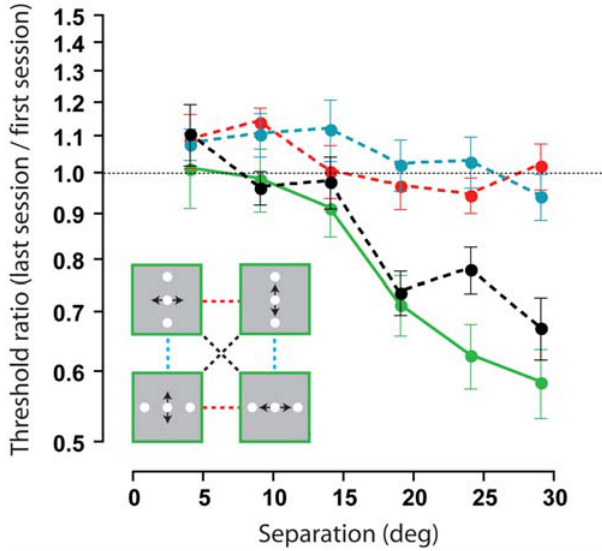
Figure 4. Transfer of learned improvements between task and stimulus configurations. Ratio of mean positional thresholds obtained on the first and last days, collapsed across conditions and plotted as a function of stimulus separation. Trained improvements in performance did not transfer to different configurations (dashed blue line) or tasks (dashed red line), but did transfer between task-configuration combinations when there was common spatial axis to the judgement (dashed black line). For comparison, the solid green line shows averaged learned improvements obtained within each task-configura- tion combination. Error bars are SEM.